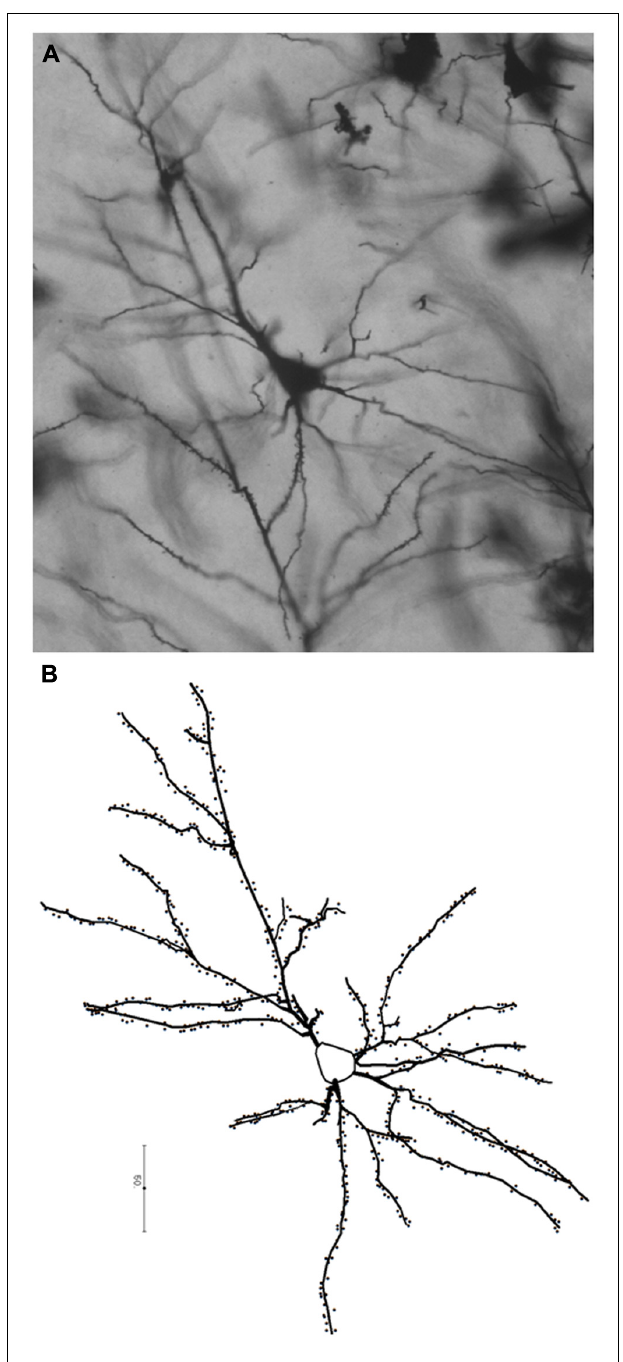
FIGURE 1 | Photomicrograph (A) and a schematic representation (B) of a pyramidal neuron from the human prefrontal cortex (BA 10) processed with the Golgi–Kopsch method. Scalebar in (B) is in